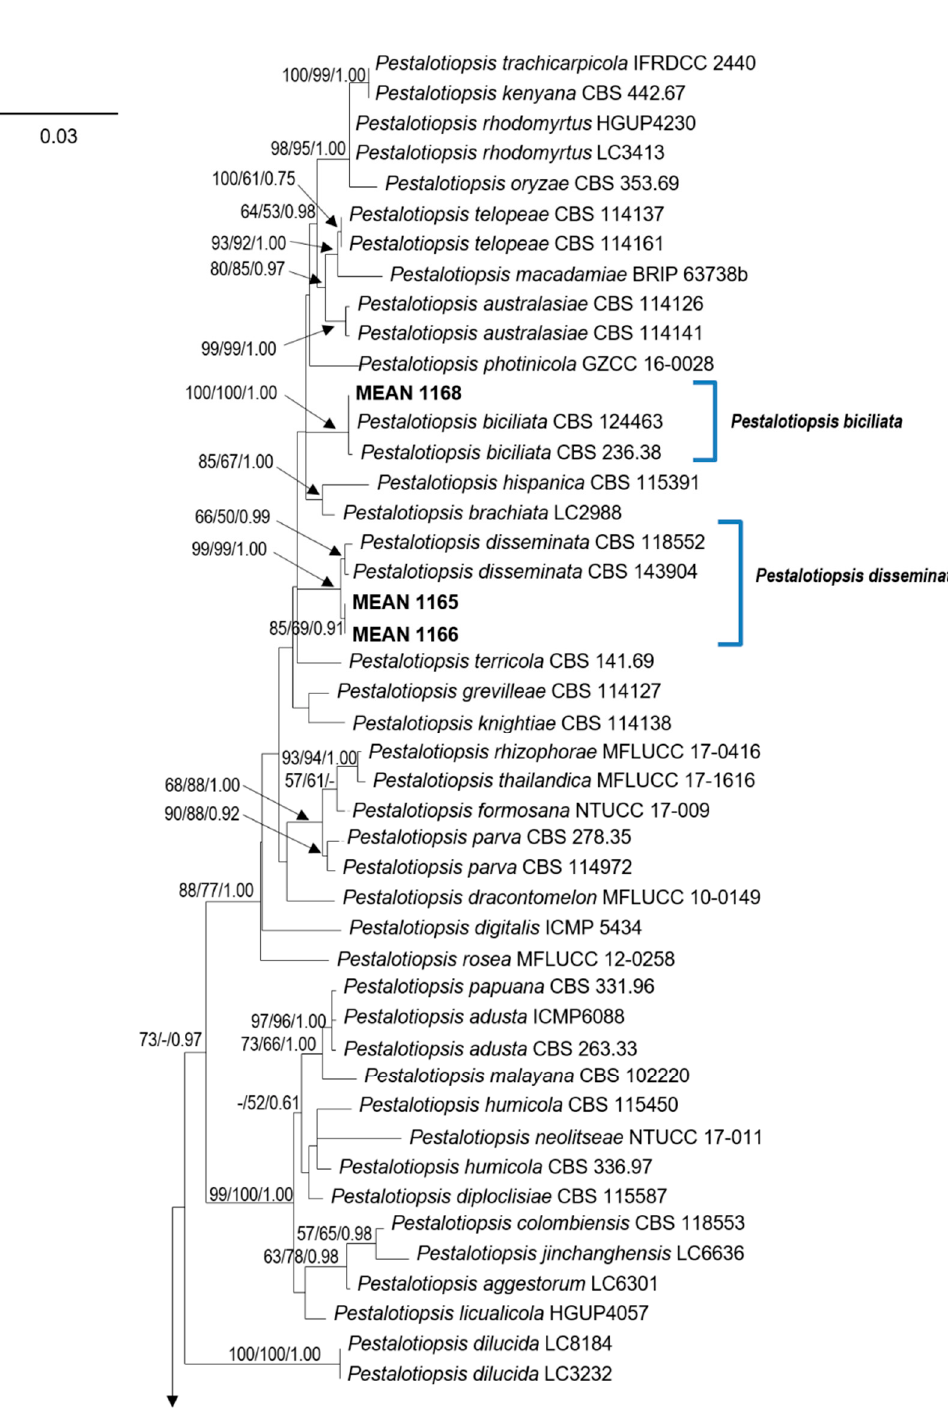
Figure 1. Phylogram generated from maximum likelihood (ML) analysis based on combined ITS, TUB and TEF sequence alignment for species of Pestalotiopsis. The best scoring ML tree with a final likelihood value of -10646.254559 is presented. The tree was rooted to Neopestalotiopsis australis (CBS 114159) and N. protearum (CBS 114178). Maximum likelihood and maximum parsimony bootstrap support values ≥ 50% and Bayesian Inference posterior probabilities ≥ 0.90 (MLBS/MPBS/BIPP) are given at the nodes in common branches. The isolates obtained in this study are in bold. The scale bar represents the expected number of changes per